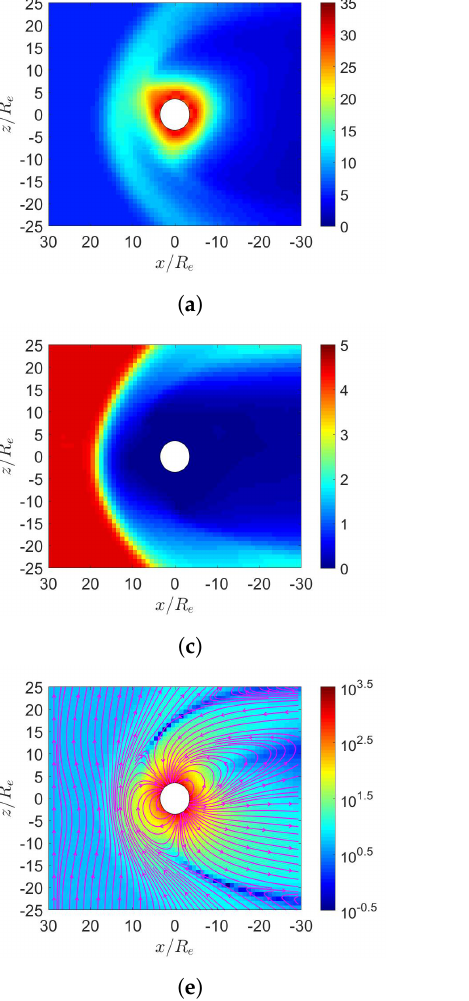
Figure 2. Distributions around Earth of magnetosphere. ( a ) n (cm − 3 ), ( b ) ¯ u xz (km/s), ( c ) magnetosonic Mach number, ( d ) P (nPa), ( e ) ¯ B xz (nT), ( f ) J y ( µ A/m 2 ); northward IMF in June, t = 27